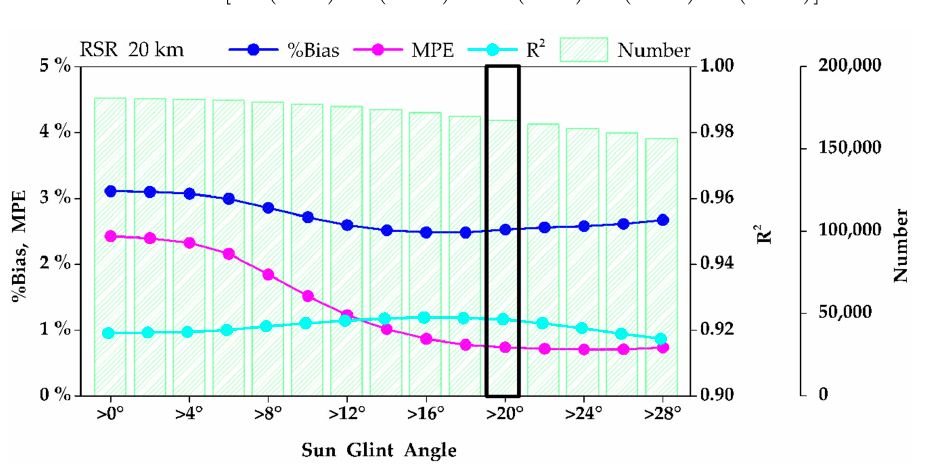
Figure 3. Relative bias (%Bias), mean percentage error (MPE in percent), coefficient of determination (R 2 ), and number in Himawari-8/AHI and Terra/CERES data sets as a function of sun glint (SG) angle (15 October 2015).